Question: Provide a one-line summary of what is displayed.
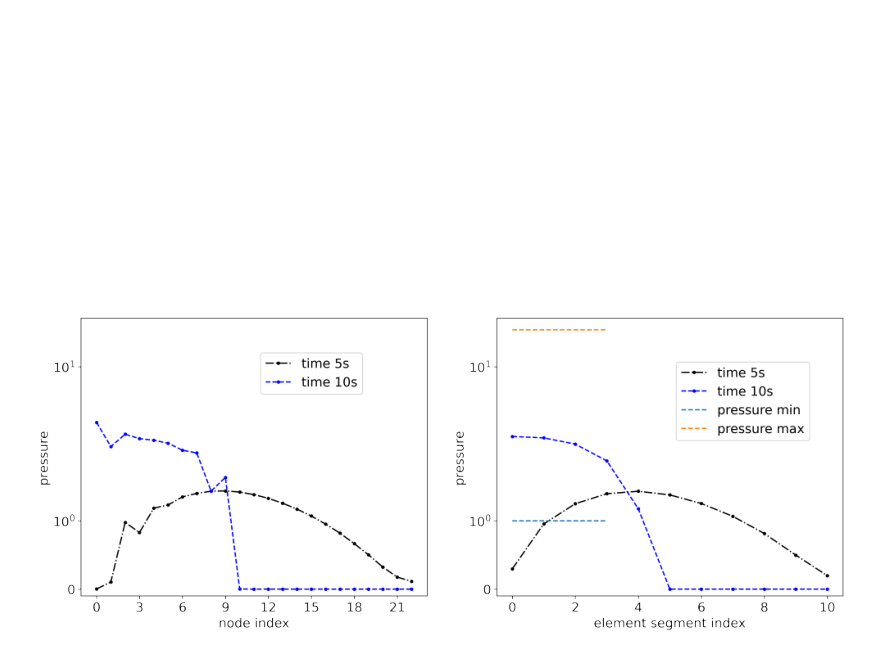
Answer: Pressure distribution on the contact surface for the initial design: nodal pressure (left) and averaged pressure on element segments (right).